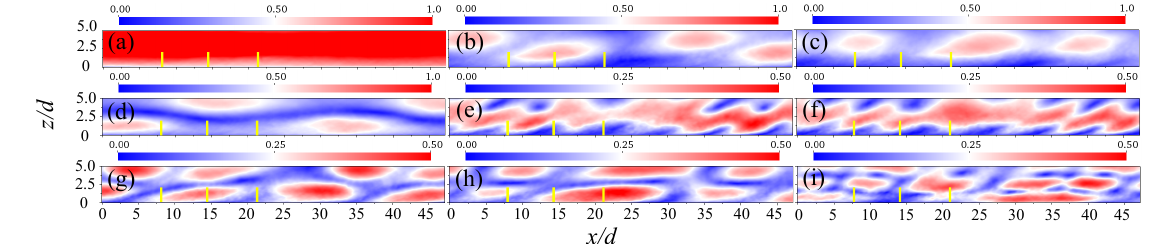
Figure 14. Normalized Fourier-POD mode for wave-number, k y d = 0.4. ( a ) m = 0, ( b ) m = 1, ( c ) m = 2, ( d ) m = 3, ( e ) m = 4, ( f ) m = 5, ( g ) m = 6, ( h ) m = 7, ( i ) m = 8. Red-blue contours indicate the normalized velocity magnitude modes,